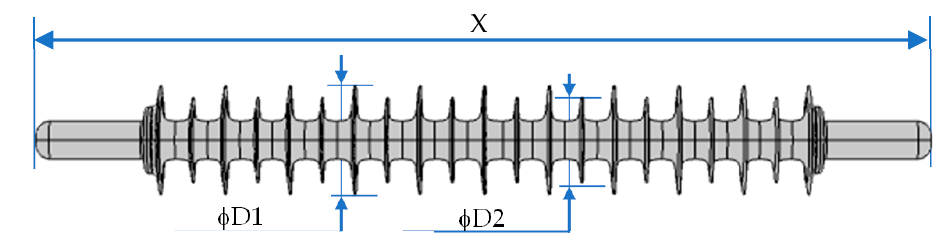
Figure 1. Geometry of the Sediver composite insulator [18].